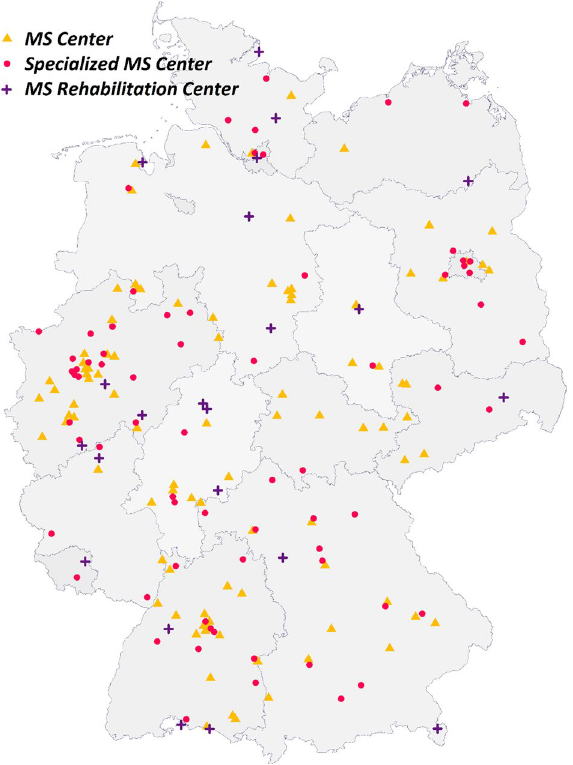
Figure 1. Distribution of 187 MS centres participating in the GMSR across Germany. These include 70 specialised MS centres (red circle), 95 MS centres (orange triangle), and 22 MS rehabilitation centres (purple cross). GMSR German Multiple Sclerosis registry. The map was created with R 4.0 based on data from gadm.org.